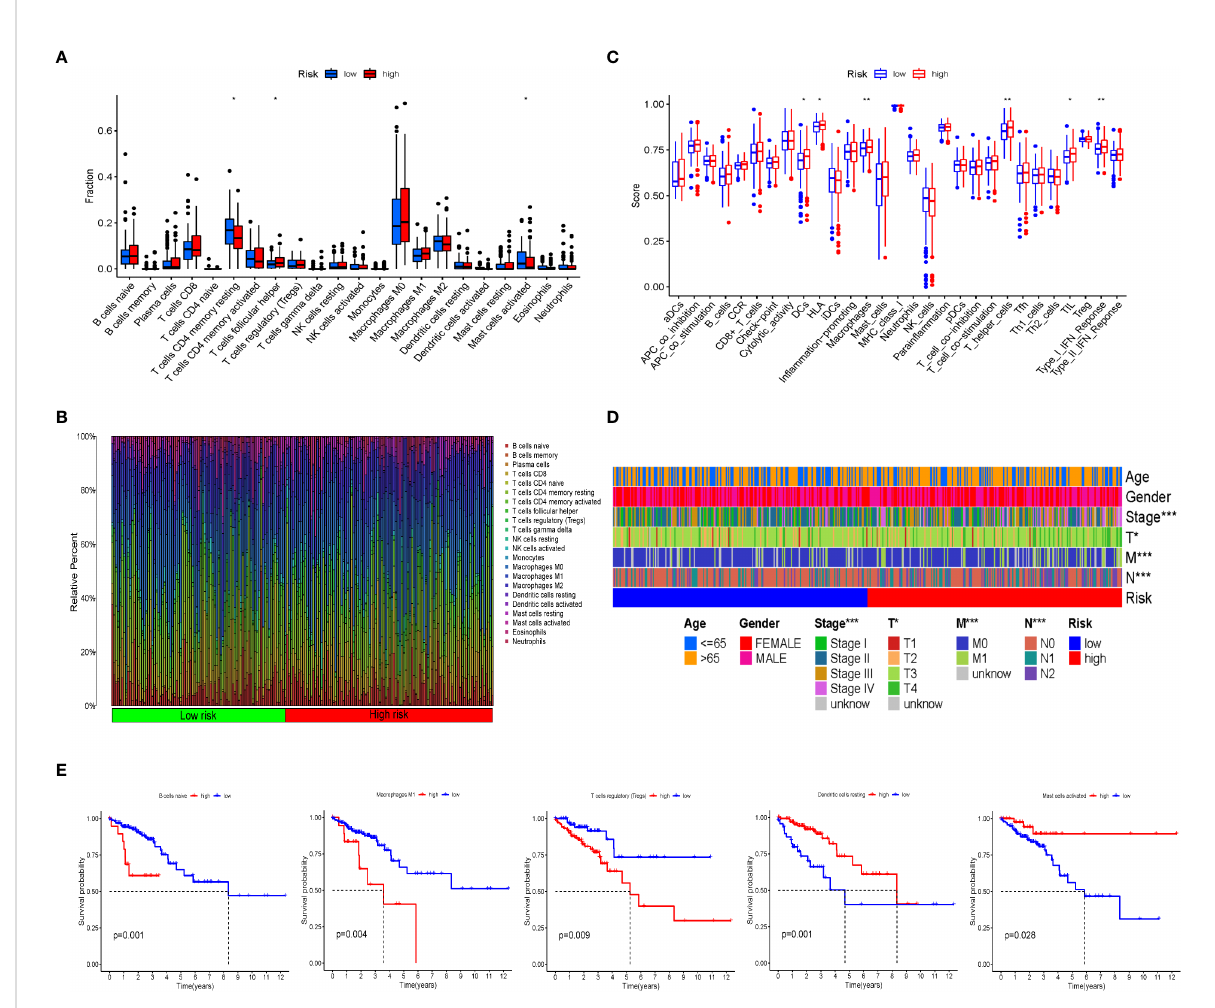
FIGURE 3 Immune cell in fi ltration and immune function scores between IRGPI subgroups. (A) Comparison of tumor immune cell in fi ltration between two IRGPI subgroups. Signi fi cant statistical differences between the two subgroups were assessed using the Wilcoxon test (* p < 0.05, ** p < 0.01). (B) The proportions of TIME immune cells in different IRGPI subgroups. (C) Comparison of immune function score between two IRGPI-related CRC subgroups. Signi fi cant statistical differences between the two subgroups were assessed using the Wilcoxon test (* p < 0.05, ** p < 0.01). (D) Clinicopathological information of the IRGPI-related CRC subgroups in the TCGA cohort. Age, gender, tumor stage, and T, M, and N are shown as patient annotations (* p < 0.05, ** p < 0.01, *** p < 0.001). (E) Kaplan – Meier survival analysis of the TME cells and immune function IRGPI subgroups in the TCGA